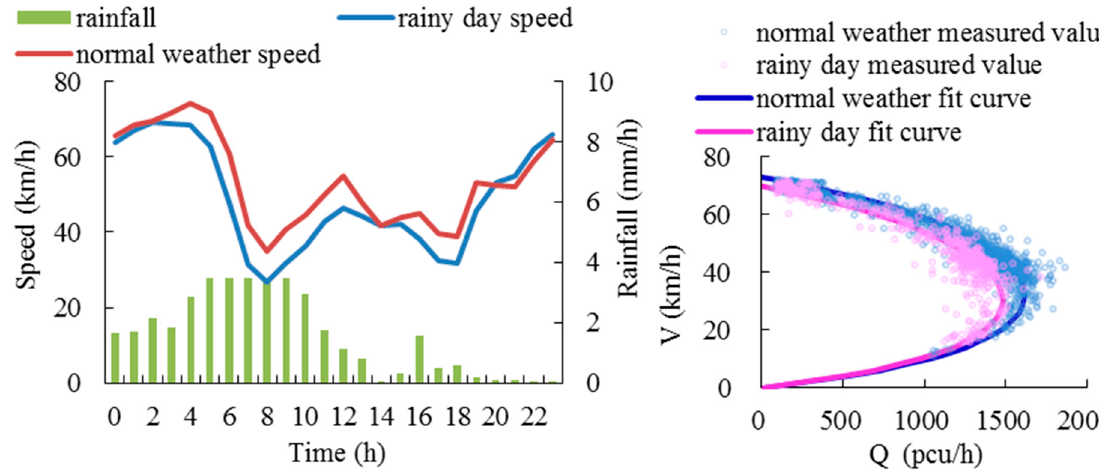
Figure 11. Fundamental diagrams of rainy days and normal days.